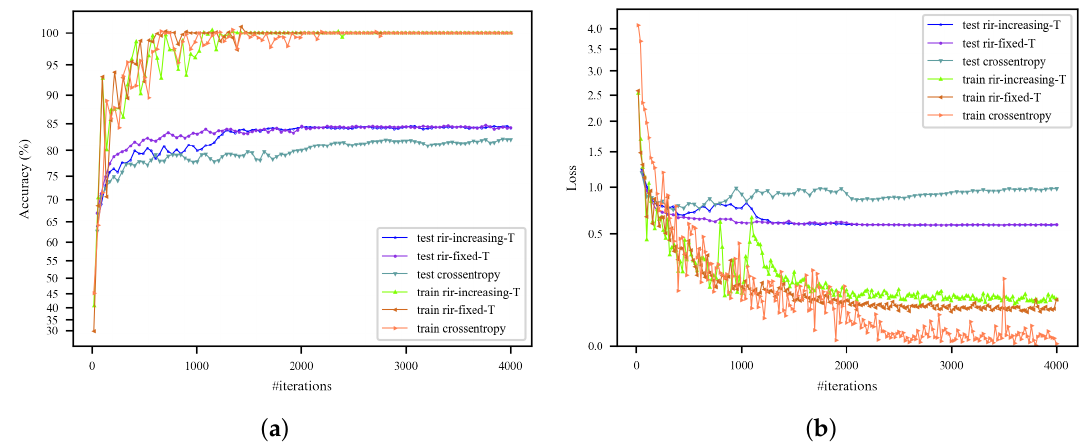
Figure 10. Training accuracy and loss curves with AlexNet-based architectures on the NWPU dataset (training ratio = 10%). ( a ) Training and testing accuracy curves; ( b ) training and testing loss